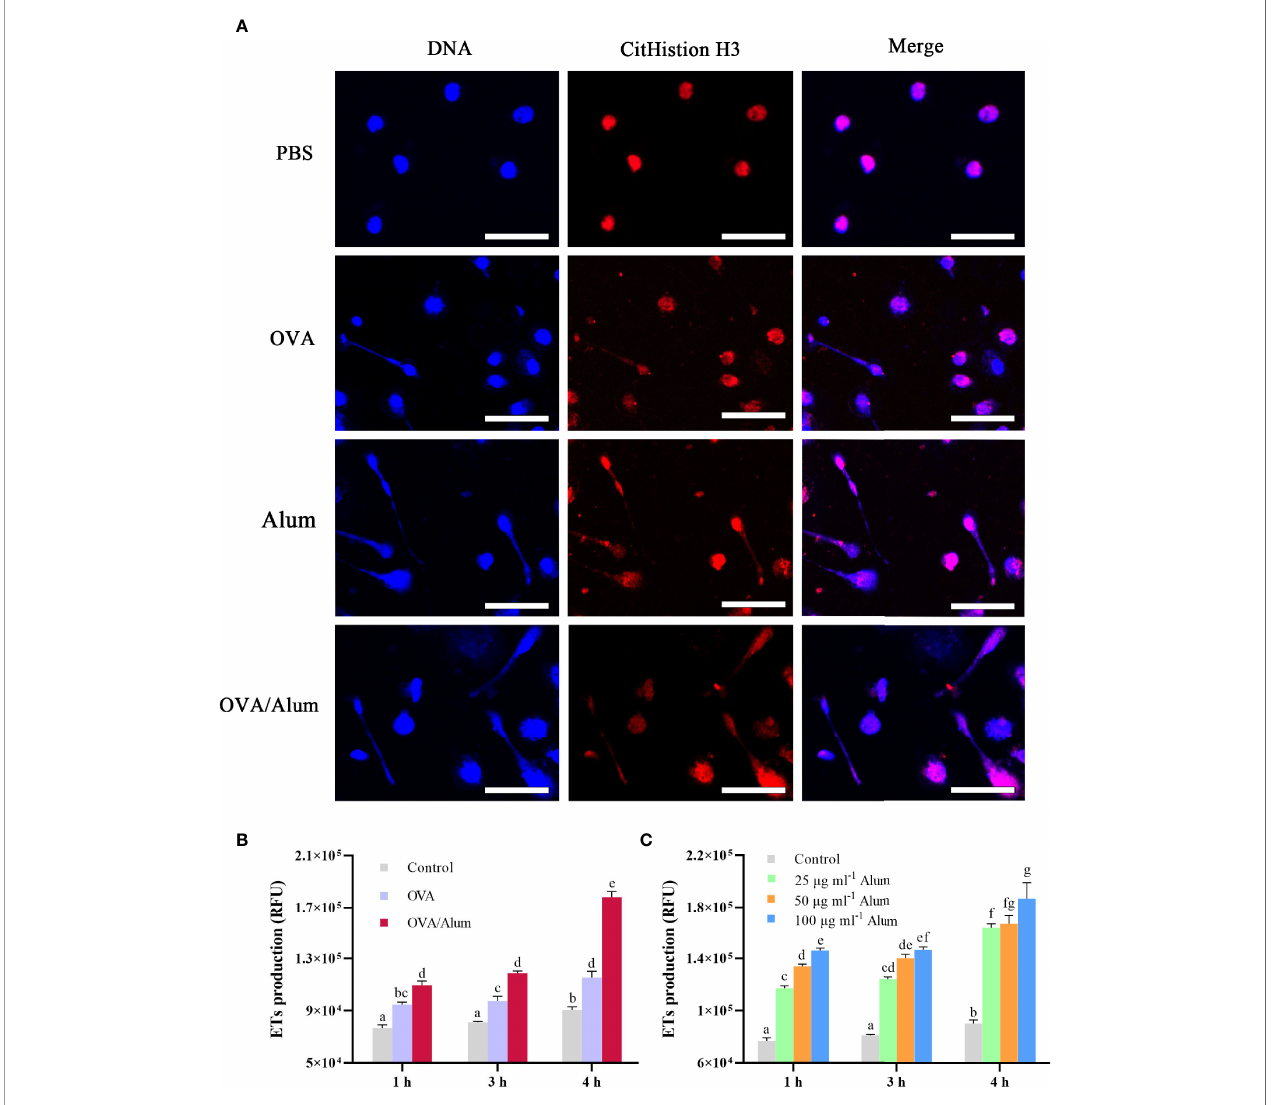
FIGURE 2 | Ovalbumin (OVA) and Alum trigger extracellular trap (ET) formation of peritoneal cells in vitro . (A) Fluorescence microscopy of peritoneal cells after incubation with OVA, Alum, OVA/Alum mixture, and phosphate-buffered saline (PBS) at 3 h. Co-localization of expelled DNA (blue) with the CitHistion H3 (red) was observed. Scale bars, 20 µm. (B) Time course production of ETs by peritoneal cells after stimulation with OVA, Alum, or OVA/Alum for different times. ET production was measured by fl uorescence of Sytox Green bound to extracellular DNA in plate reader assays. (C) Production of ETs was quanti fi ed after stimulation with different concentrations of Alum. The results shown are from three independent experiments. Different letters above the bar represent the statistical signi fi cance ( p < 0.05). Error bars represent standard errors of